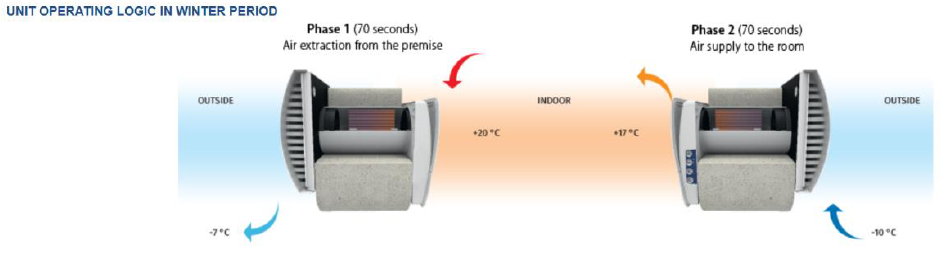
Figure 2. Principle of how the wall-type ventilation unit works [58].